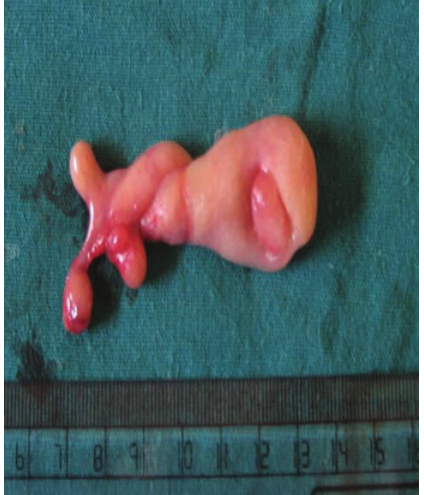
Figure 4: The excised tonsillar lipoma along with the stalk.